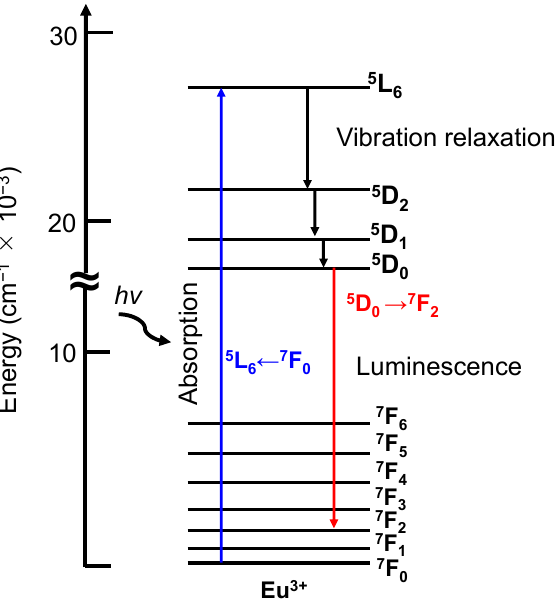
Figure 7. Partial energy diagram of Eu 3+ as an example of complex. As an example, the blue arrow is 5 L 6 ← 7 F 0 transition meaning excitation and the red arrow is 5 D 0 → 7 F 2 transition meaning luminescence.